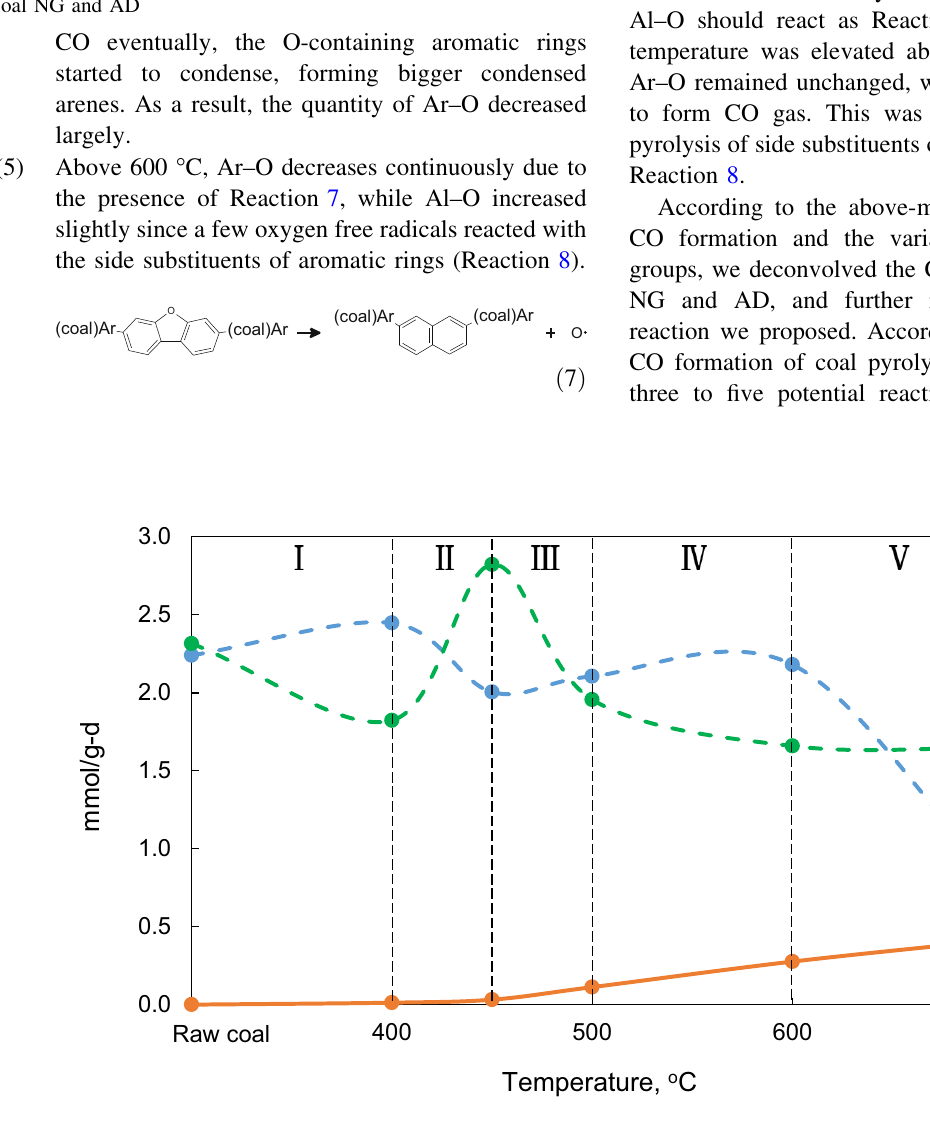
Fig. 5 Integration of CO as a function of temperature and the trends of its relevant functional groups of Al–O and Ar–O of coal NG